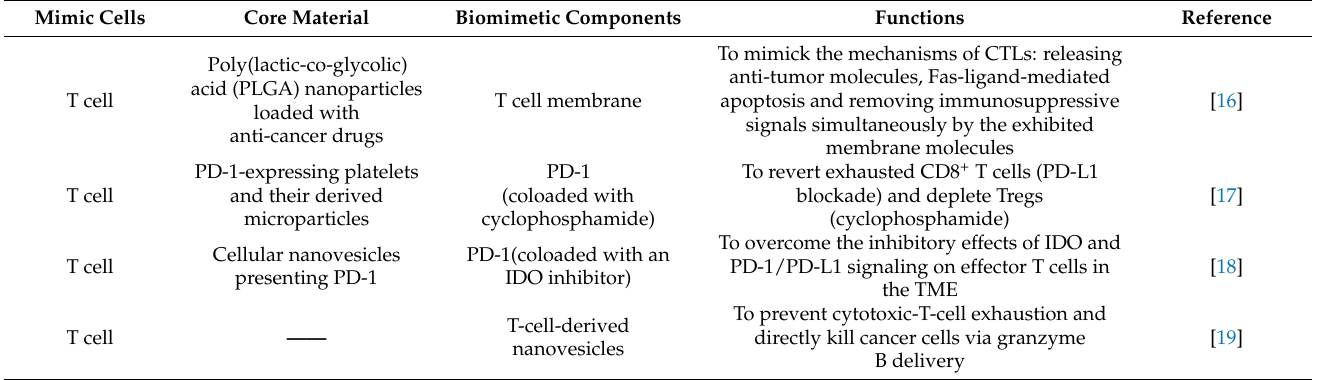
Table 1. Biomimetic strategies for cancer immunotherapy.